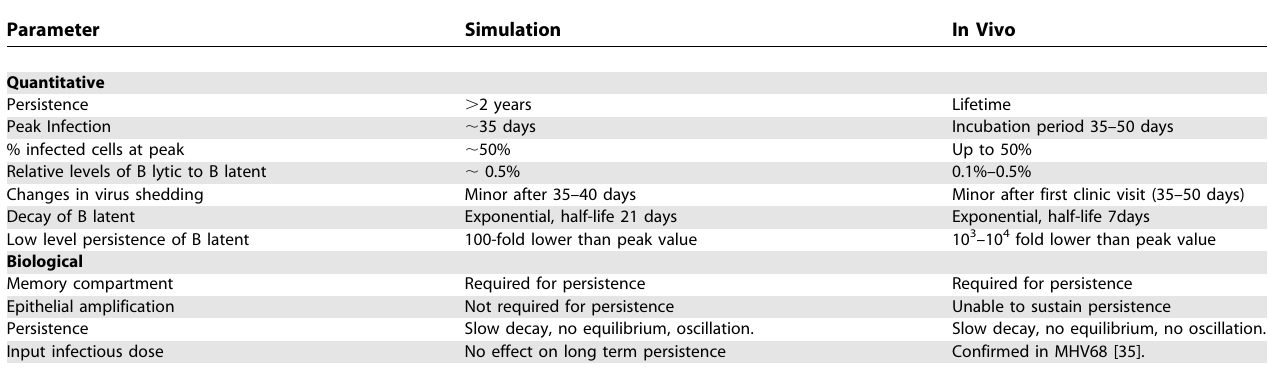
Table 2. Validation of Simulation Output Parameter